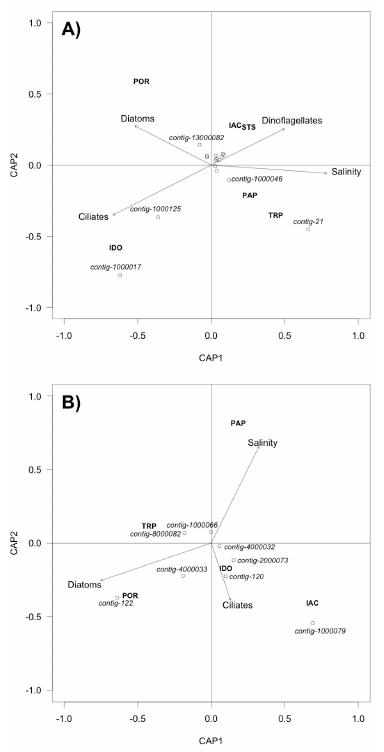
Figure 8. Triplots of distance-based redundancy analysis (db-RDA) using an unweighted UniFrac distance matrix for: ( A ) DNA virus contigs; ( B ) RNA virus contigs. Site scores are indicated by their three-letter code (see Table 2). Environmental variables are shown by arrows. Open circles show species scores for virus contigs. Some, but not all contigs are labelled.